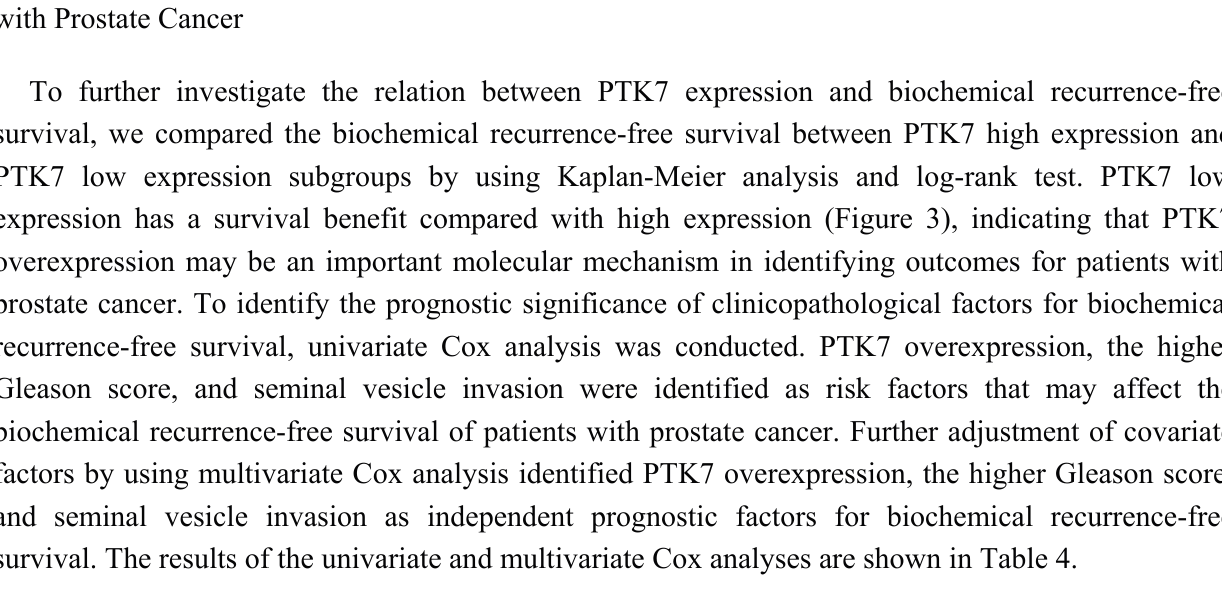
Table 4. Prognostic value of PTK7 expression for the biochemical recurrence-free survival in univariate and multivariate analyses by Cox